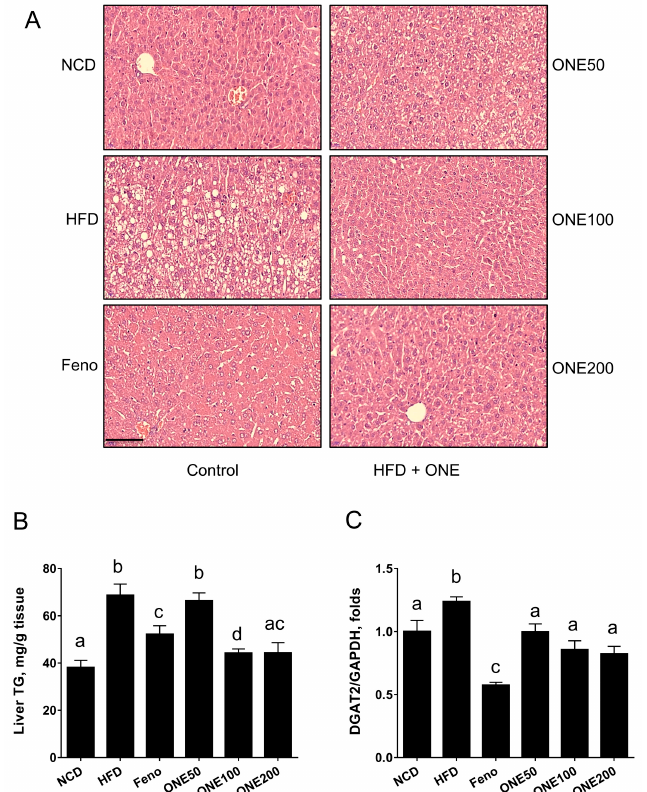
Figure 3. ONE prevents hepatosteatosis in mice fed HFD. After adjustment for one week, mice fed NCD or HFD were treated with fenofibrate or various doses of ONE. After sacrifice, mouse livers were stained with hematoxylin and eosin (H&E) ( A ). TG levels in livers were measured using colorimetric enzymatic method ( B ). Diglyceride acyltransferase (DGAT2) mRNA expression was determined using qRT-PCR ( C ). All values are presented as mean ± SEM ( n = 7). Different letters indicate statistical significance among treatment groups. Bar indicates 100 μ m.